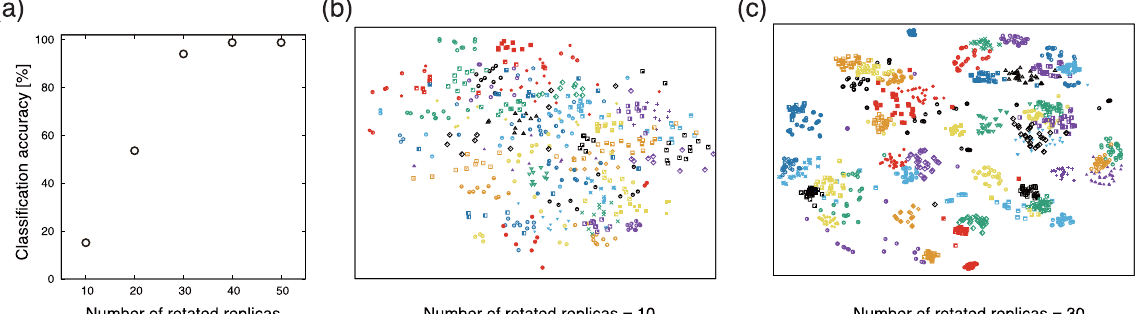
Figure 3. ( a ) Classification accuracies for the rotation invariance of the R3DVS descriptors. The horizontal axis indicates number of the rotated replicas that are fed into the CNNs. The vertical axis indicates classification accuracy averaged over 20 test results for randomly-chosen 50 samples of the oxides. ( b ) and ( c ) are t-SNE feature visualisations projected from the last Leaky ReLU layers embedded in the convolutional layers with 10 and 30 rotated replicas, respectively. The types of the marks indicate the 50 targets of the oxides to be